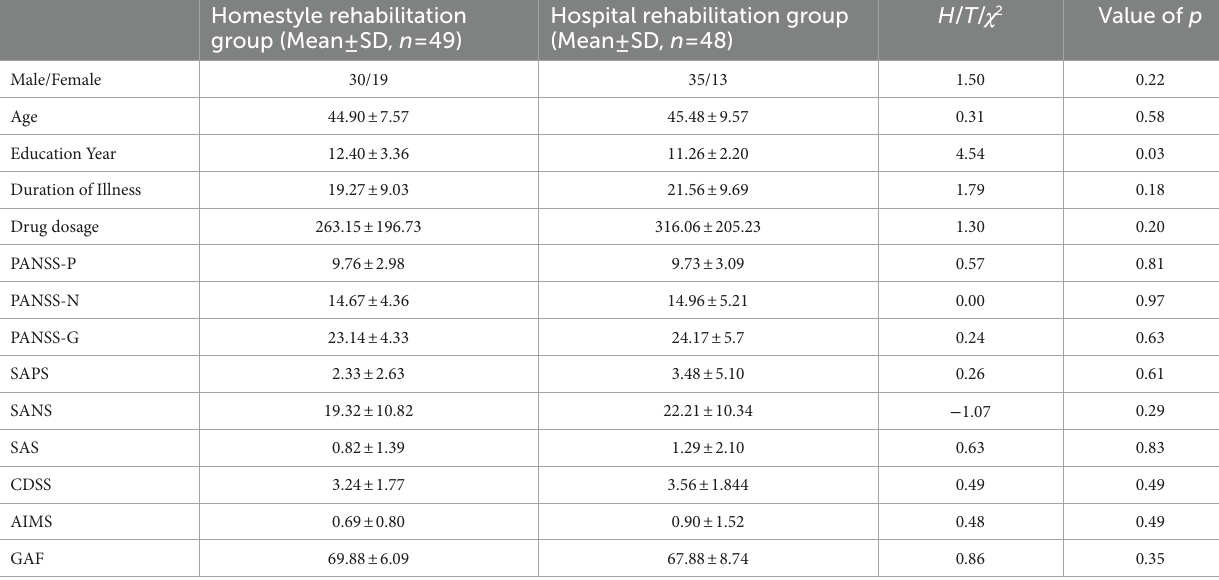
TABLE 1 The basic information for homestyle rehabilitation group and hospital rehabilitation group. Homestyle rehabilitation group (Mean ± SD, n =